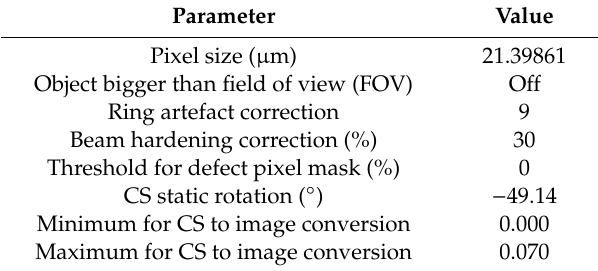
Table 4. Selected, more important reconstruction